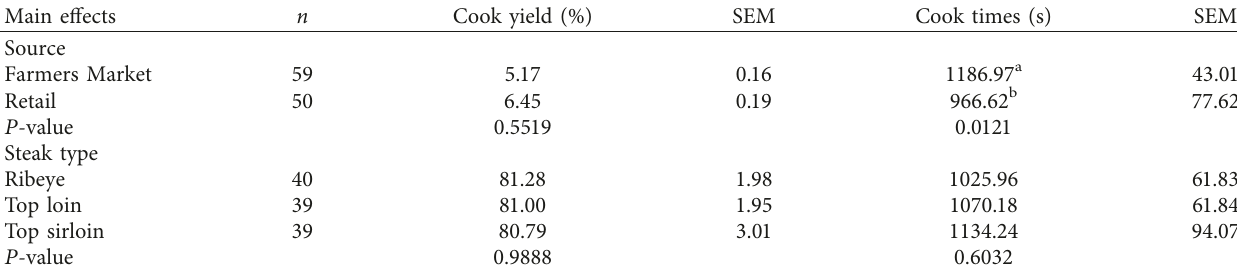
Table 5: Least squares means for cook yields and times by source and steak type main effects.